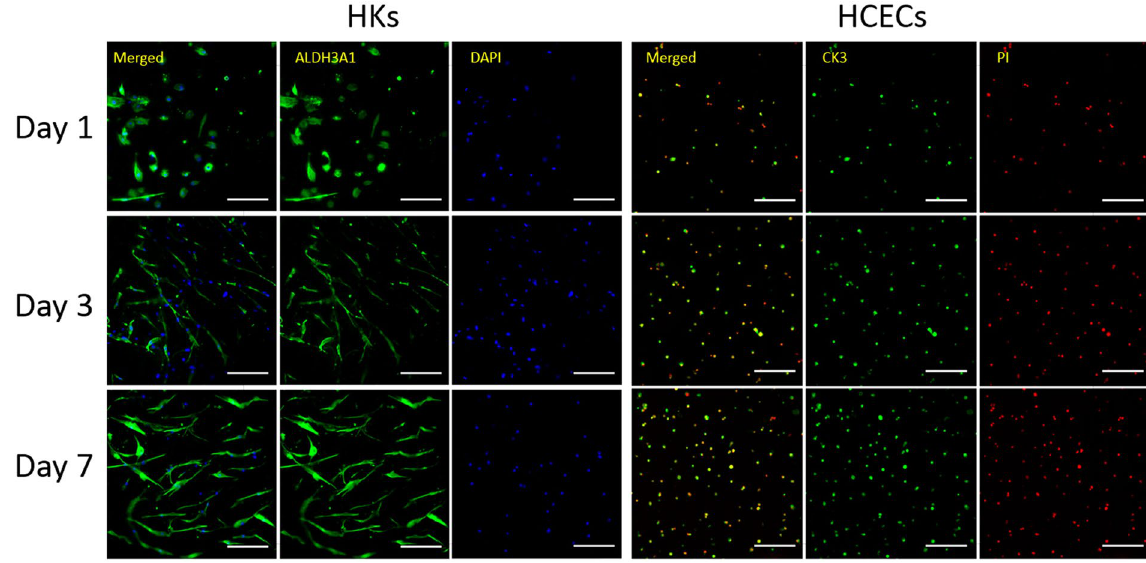
Figure 9. Protein expression of specific markers in HKs within hybrid scaffolds. Images (left) show the fluorescent staining of ALDH3A1 (green) and nuclei (blue) in HKs after being cultured for 1, 3, and 7 days. Protein expression of specific markers in HCECs seeded on the surface of hybrid scaffolds. Images (right) show fluorescent staining of CK3 (green) and nuclei (red) in HCECs after being cultured for 1, 3, and 7 days. (scale bar, 200 μ m).